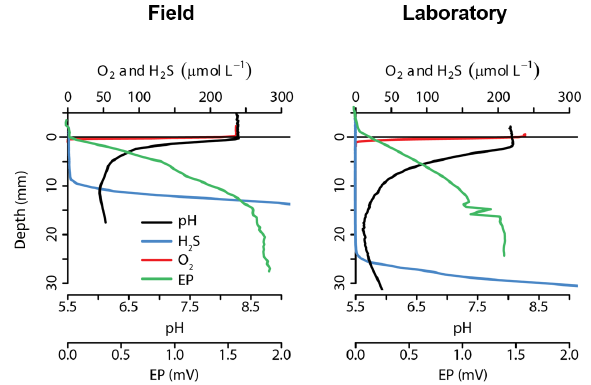
Figure 3. High-resolution depth profiles reveal the typical finger- print of cable bacteria activity in sediments near a bivalve reef (Cocksdorp, the Netherlands). Left panel: field measurements on intact sediment cores. Profiles were recorded within 3h of core col- lection. Right panel: incubation of sediment from the same location under laboratory conditions. Sediment was sieved and homogenized before incubation. Profiles were recorded after 19